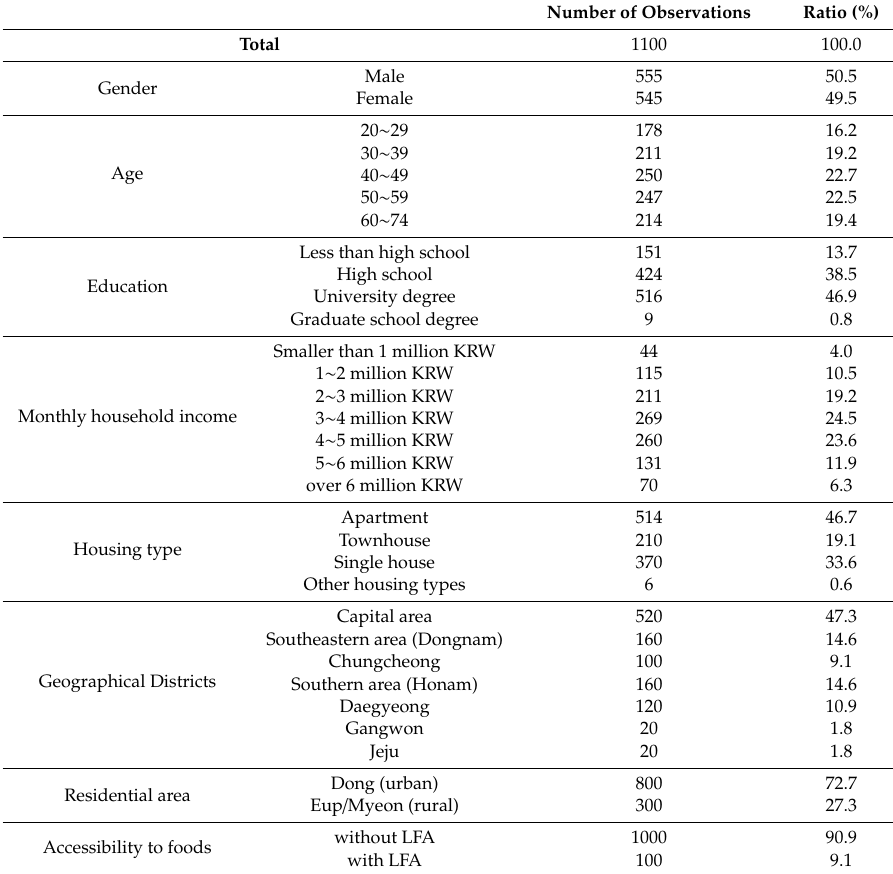
Table 2. Demographics of survey